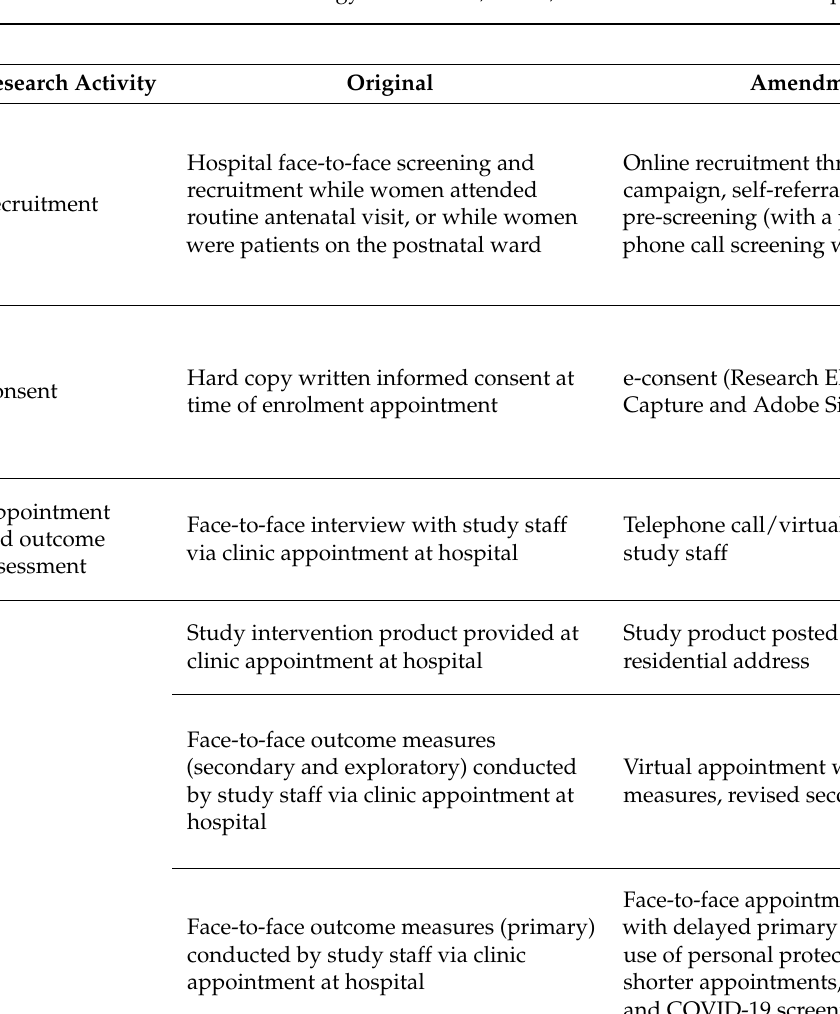
Table 1. Methodology of maternal, infant, and child nutrition studies prior to coronavirus disease 2019 (COVID-19), and amendments in the era of